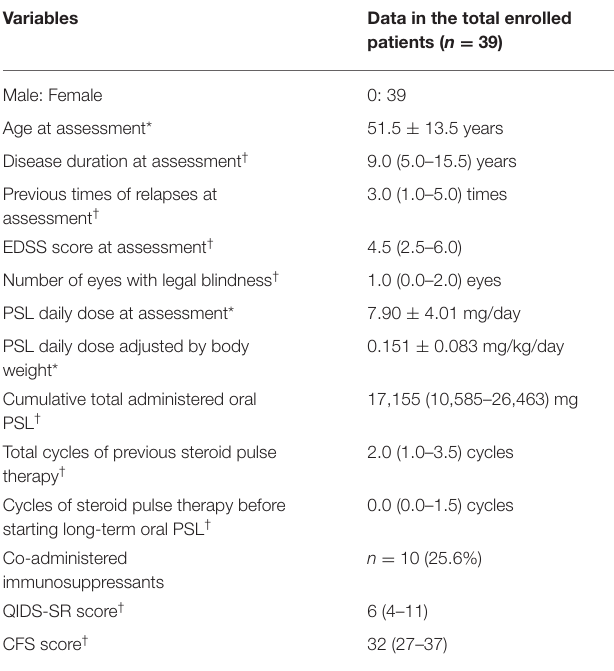
TABLE 1 | Demographic and clinical features of the enrolled 39 patients with AQP4-IgG-positive NMOSD.